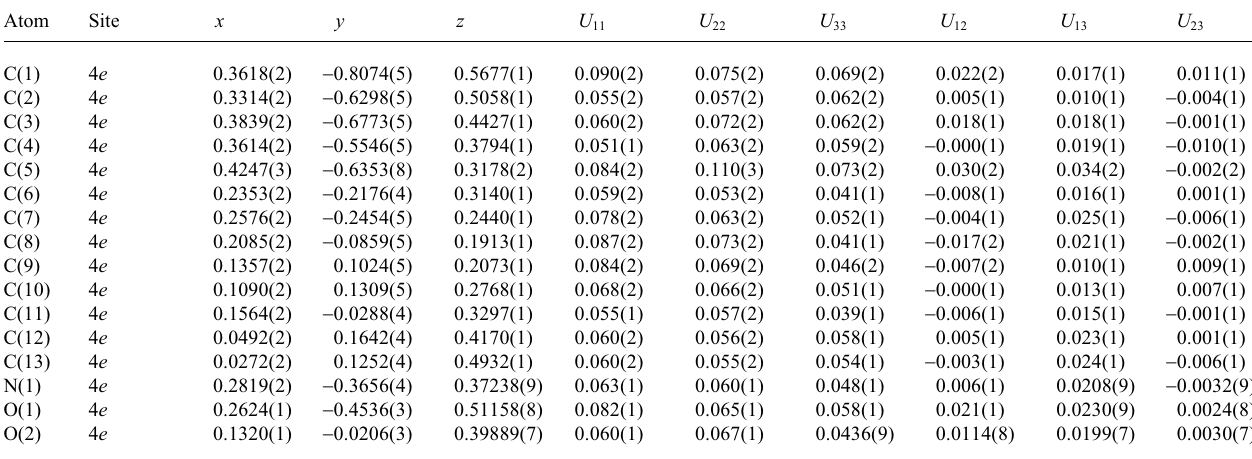
Table 3. Atomic coordinates and displacement parameters (in Å 2 )